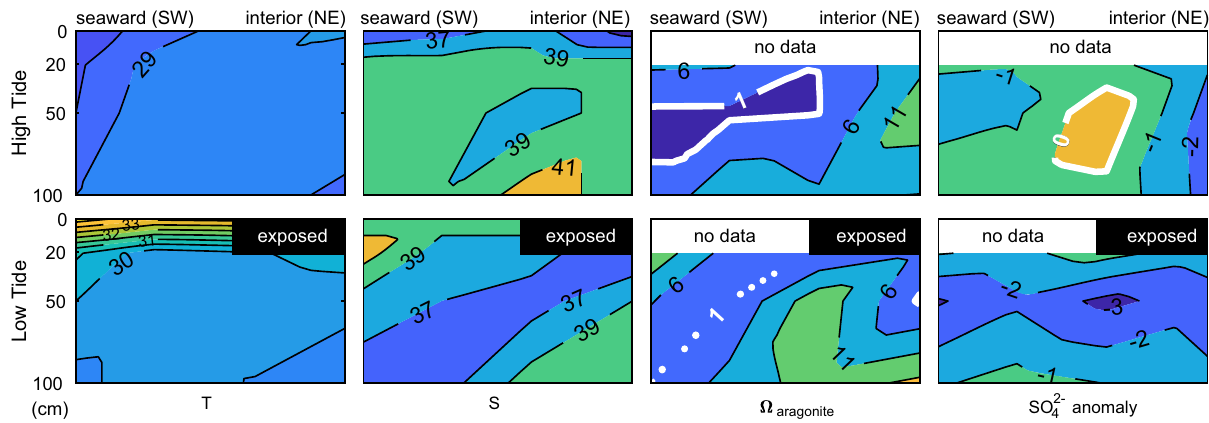
Fig. 4 Tidal bay porewater geochemistry. Contours show the low and high tide structure of tidal bay porewater temperature (T), salinity (S), aragonite saturation ( Ω ), and sulfate anomaly at the interior basin inlet on the southwestern side of Little Ambergris